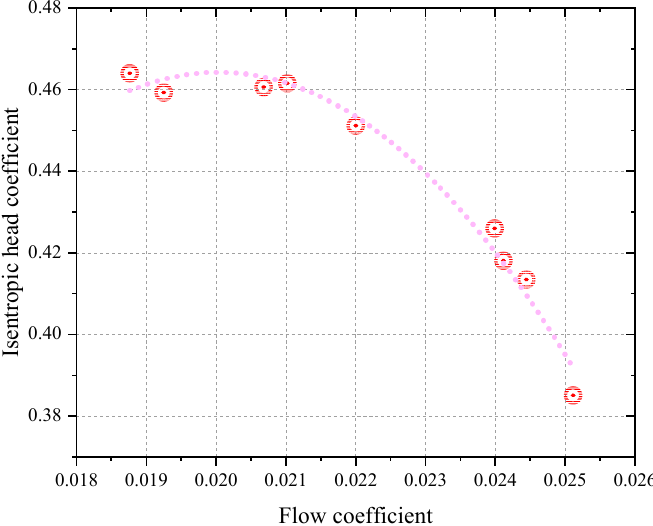
Figure 13. Dimensionless isentropic head coefficient performance curve (@ 31,000 ± 1000 RPM).